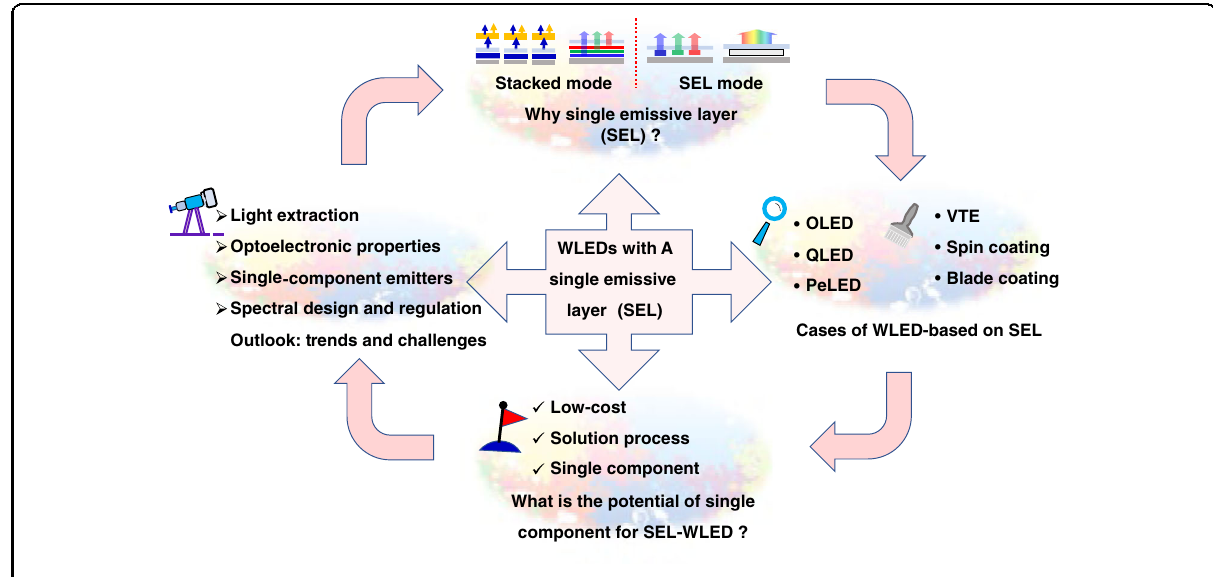
Fig. 2 An overview of the discussion sections in this